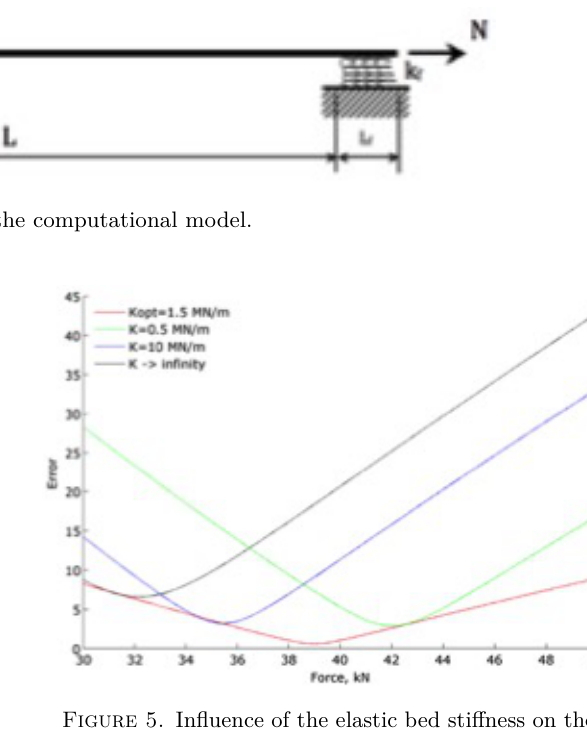
Figure 4. Error as function of bed stiffness and axial load for different sets of weight coefficients.